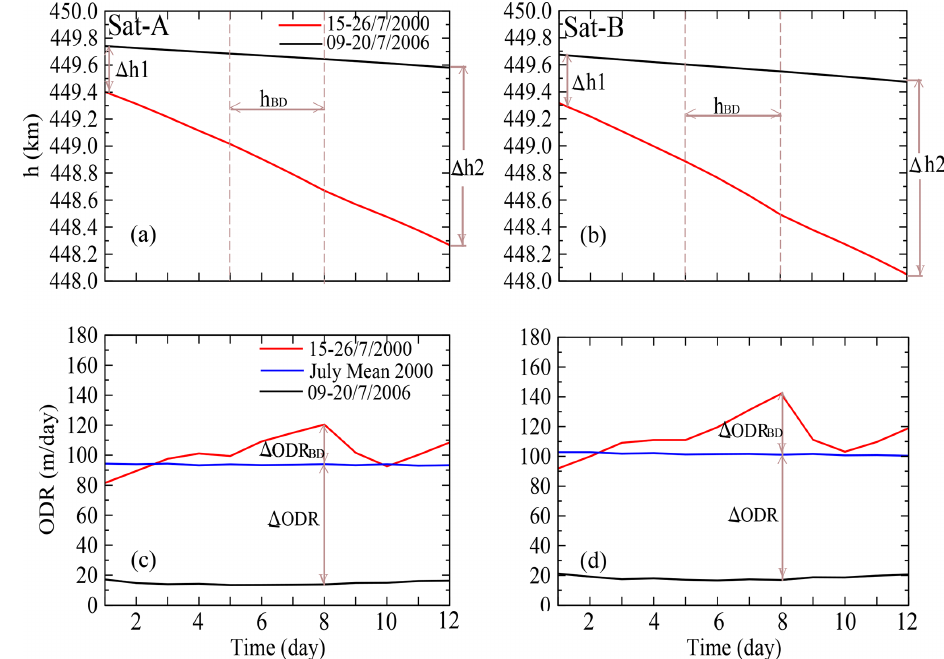
Figure 12. Contrast between the daily variations in h and ODR of Sat-A (a, c) and Sat-B (b, d) during 9–20 July 2000 and 15–26 July 2006.